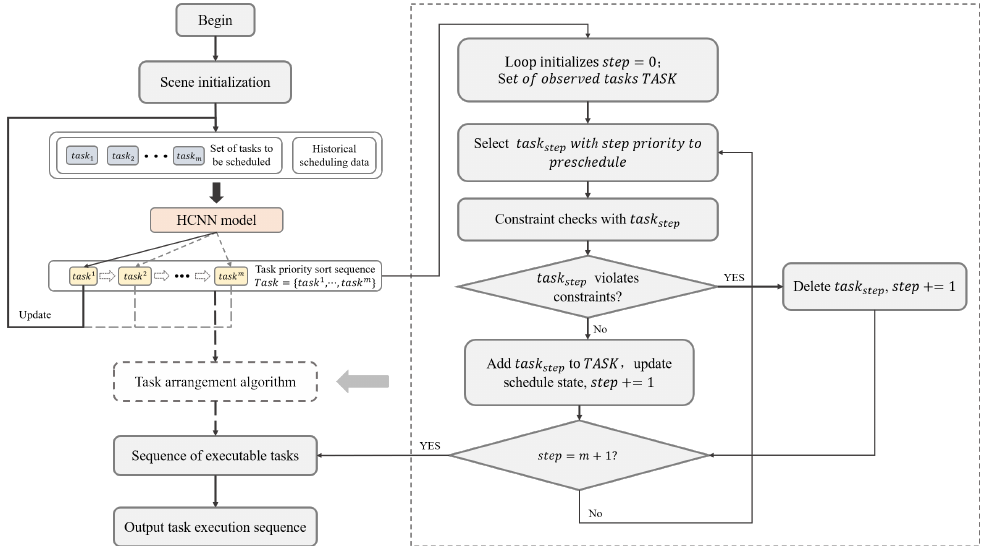
Figure 3. DRL-HA operation process